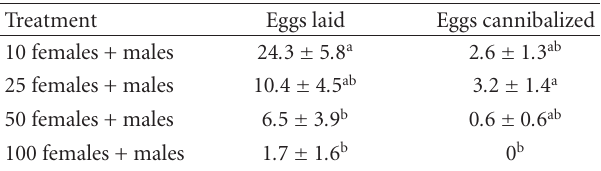
Table 1: E ff ects of crowding (of C . maculata females with males) on the mean ± SEM number of eggs laid and cannibalized per cage per day.